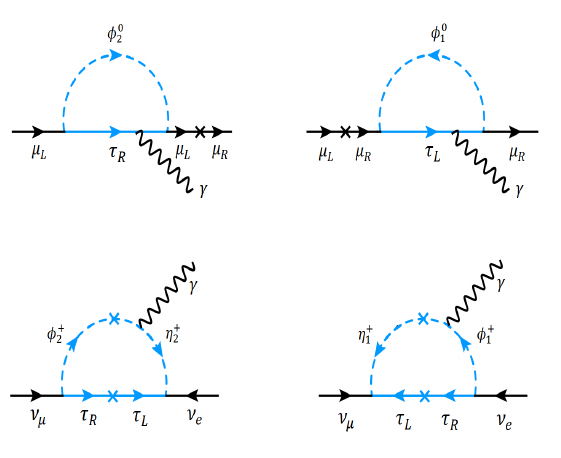
Figure 2 . The dominant contributions to ∆ a µ (top) and neutrino magnetic moment (bottom) are shown. For the neutrino magnetic moment, the outgoing photon can be emitted also from the τ lepton line. There are other diagrams, which are